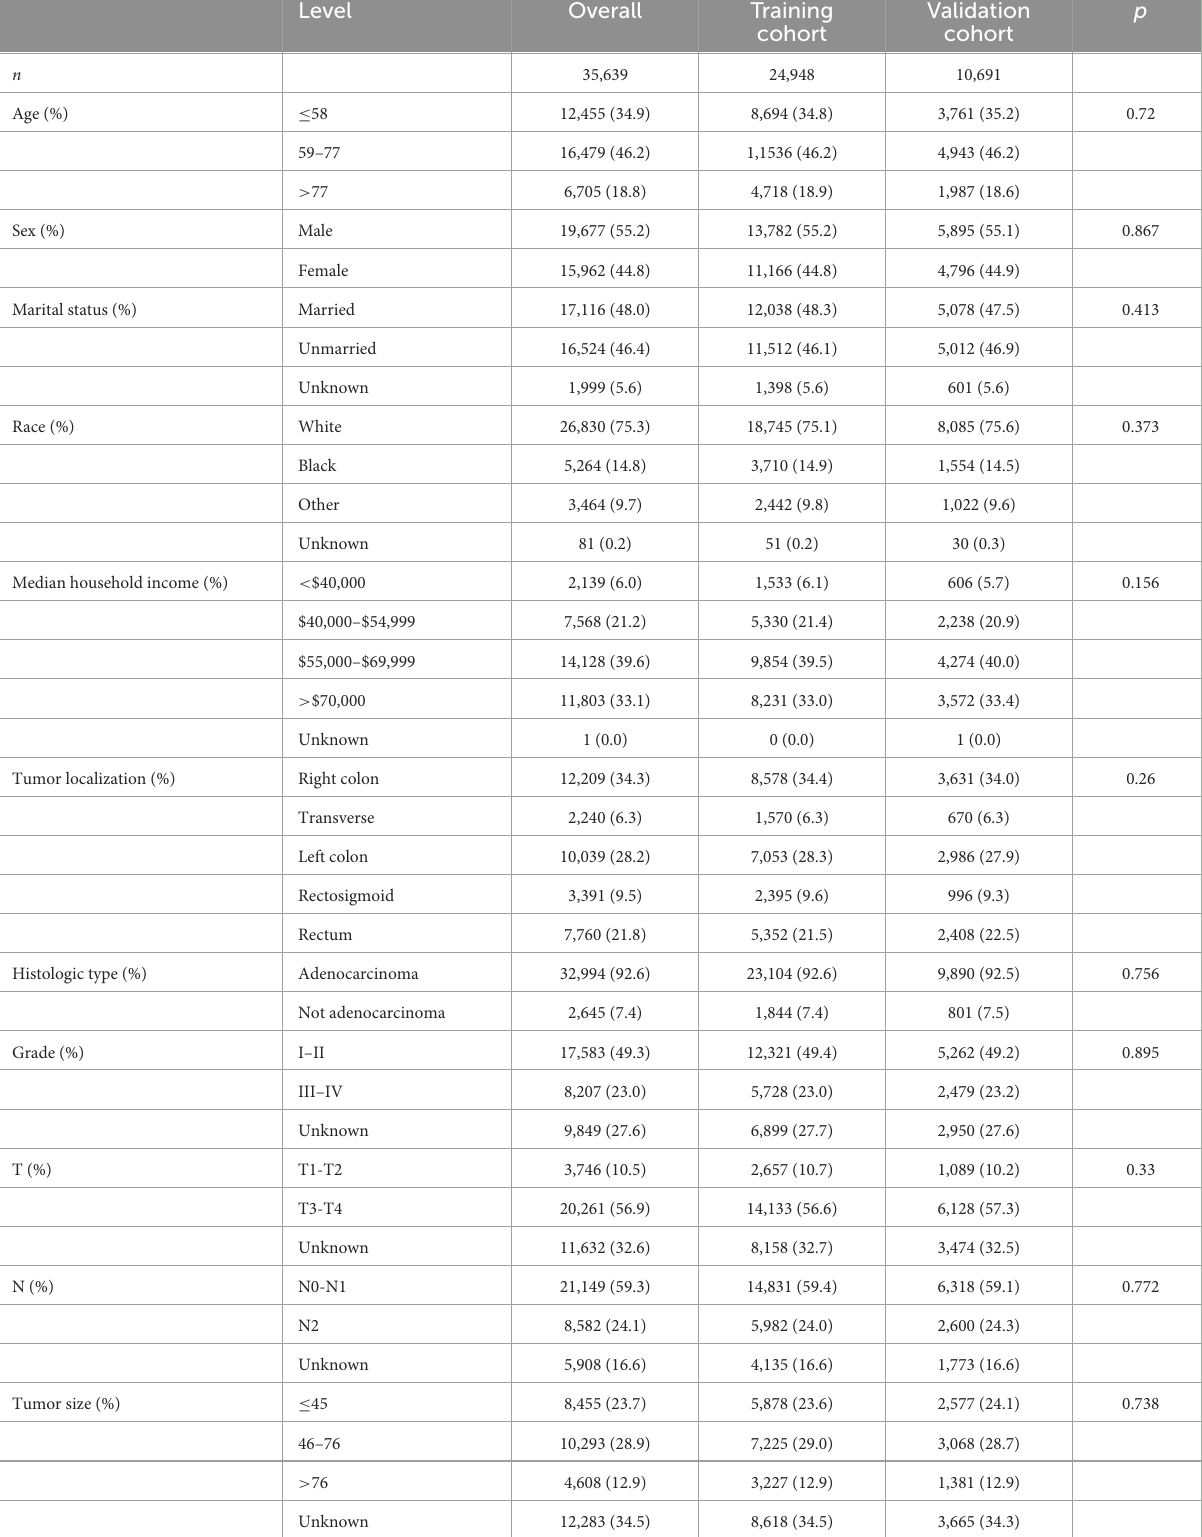
TABLE 2 Demographic information of patients with mCRC in training and validation cohorts. Level Overall Training